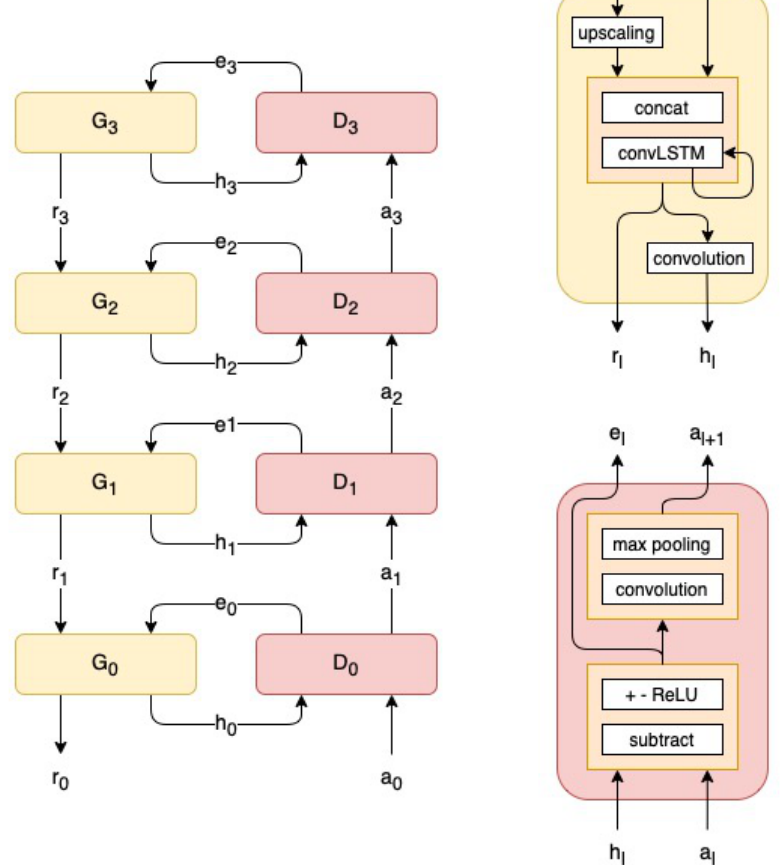
Figure 2. PredNet: on the left , the general architecture with the Discriminator and Generator blocks; on the right, the details of the two Figure 3. PredNet: on the left the general architecture with the Discriminator and Generator blocks, on the right the details of the two blocks.